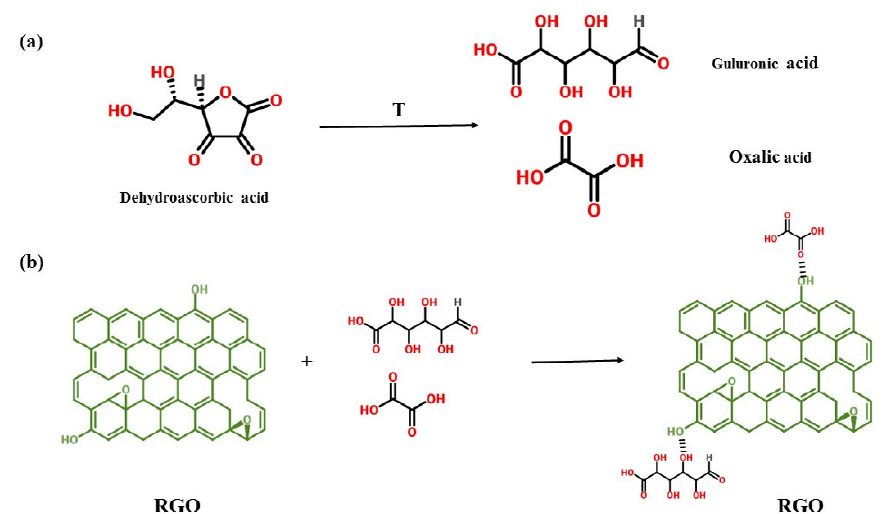
Fig. 6. Stabilization mechanism of the reduced GO aqueous suspension